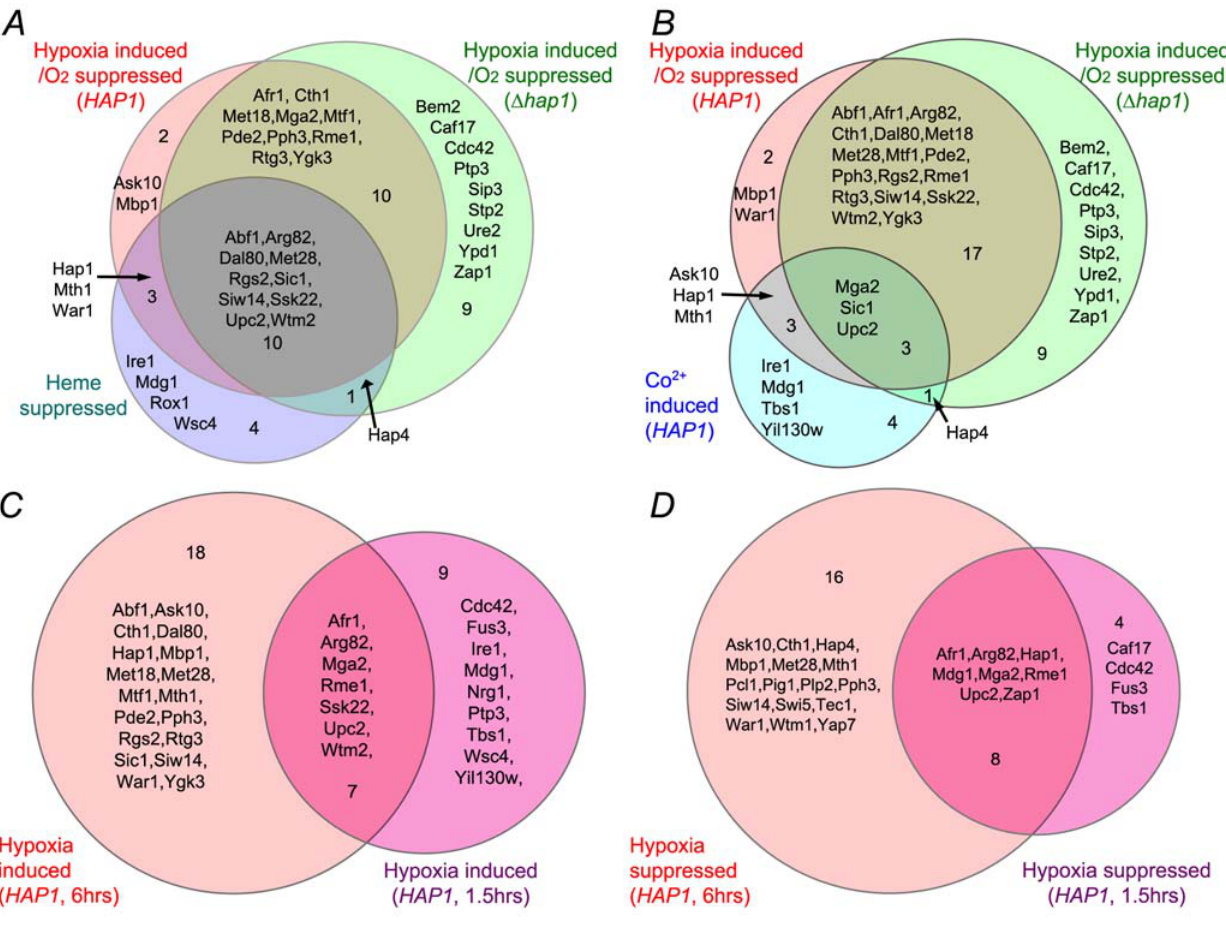
Figure 5. Venn diagrams showing the statistically significant, high ranking regulators mediating the regulation of oxygen- regulated, heme-regulated, and Co 2 + -inducible genes in HAP1 and D hap1 cells. (A) A Venn diagram illustrating the regulators involved in controlling hypoxically induced (oxygen-suppressed) genes in HAP1 and D hap1 cells, and heme-suppressed genes. (B) A Venn diagram illustrating the regulators involved in controlling hypoxically induced (oxygen-suppressed) genes in HAP1 and D hap1 cells, and Co 2 + -inducible genes. (C) A Venn diagram illustrating the regulators involved in controlling hypoxically induced (oxygen-suppressed) genes in HAP1 cells at 1.5 or 6 hours after shifting to anaerobic growth conditions. (D) A Venn diagram illustrating the regulators involved in controlling hypoxically suppressed (oxygen-induced) genes in HAP1 cells at 1.5 or 6 hours after shifting to anaerobic growth conditions.